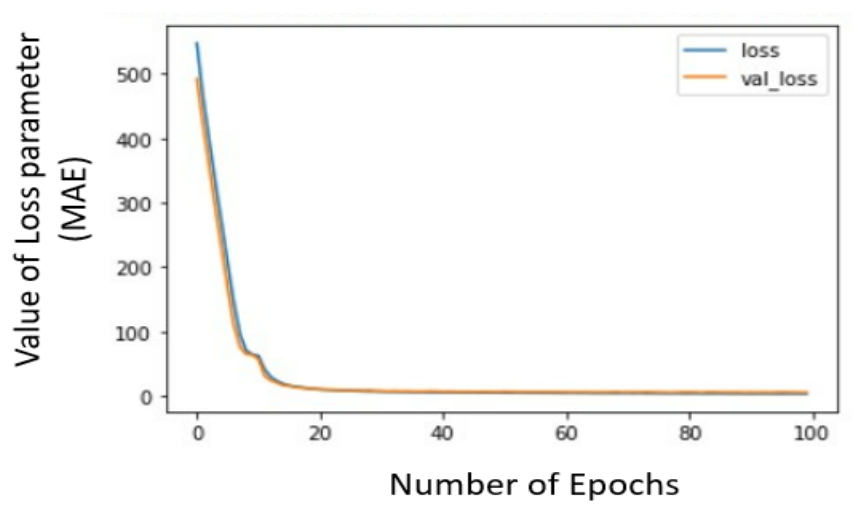
Figure 6. Training and Validation loss curves while training the model using TanH activation function (x-axis represents the number of successive epochs and the y-axis holds the value of loss parameter (MAE) for each epoch).